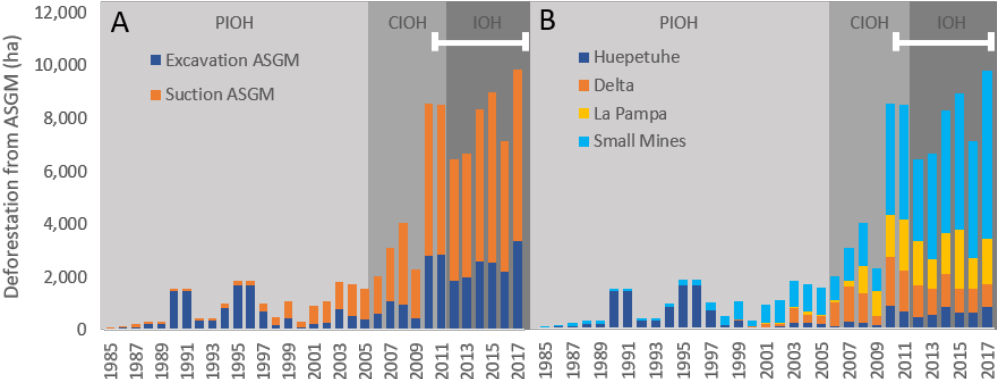
Figure 6. Annual deforestation in relation to socioeconomic predictors. Shading refers to stage of infrastructure construction: Pre-Interoceanic Highway (PIOH), Construction phase of the interoceanic highway (CIOH), and operational phase (IOH). White line and arrows indicate phase of interdictions against illegal mining by the Peruvian National Police and military. ( A ) Area deforested by mining type, either excavation (dark blue) or suction (orange). ( B ) Geography of deforestation and whether mining was contained in one of the three major mining districts or spread through small mines across the landscape.